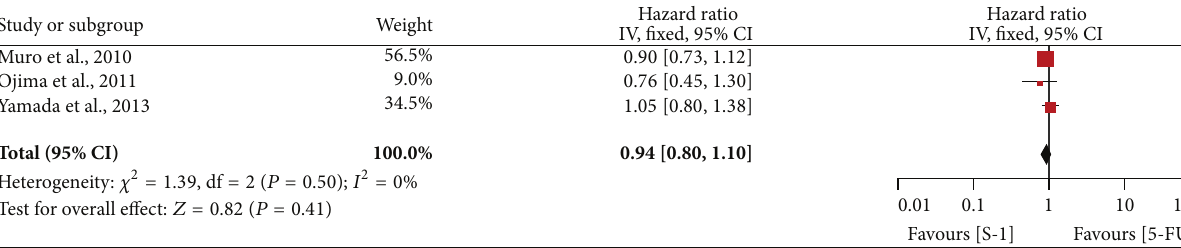
Figure 4: Forest plot of hazard ratio of overall survival.